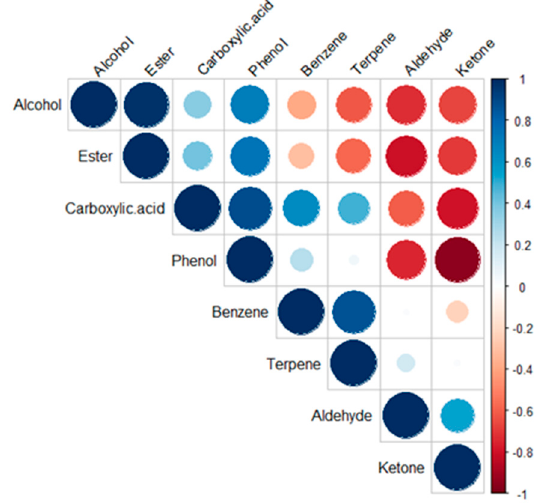
Figure 4. Correlation between di ff erent classes of VOCs during kombucha fermentation stages conducted at 30 °C (a color gradient denotes the Spearman’s correlation coe ffi cients).